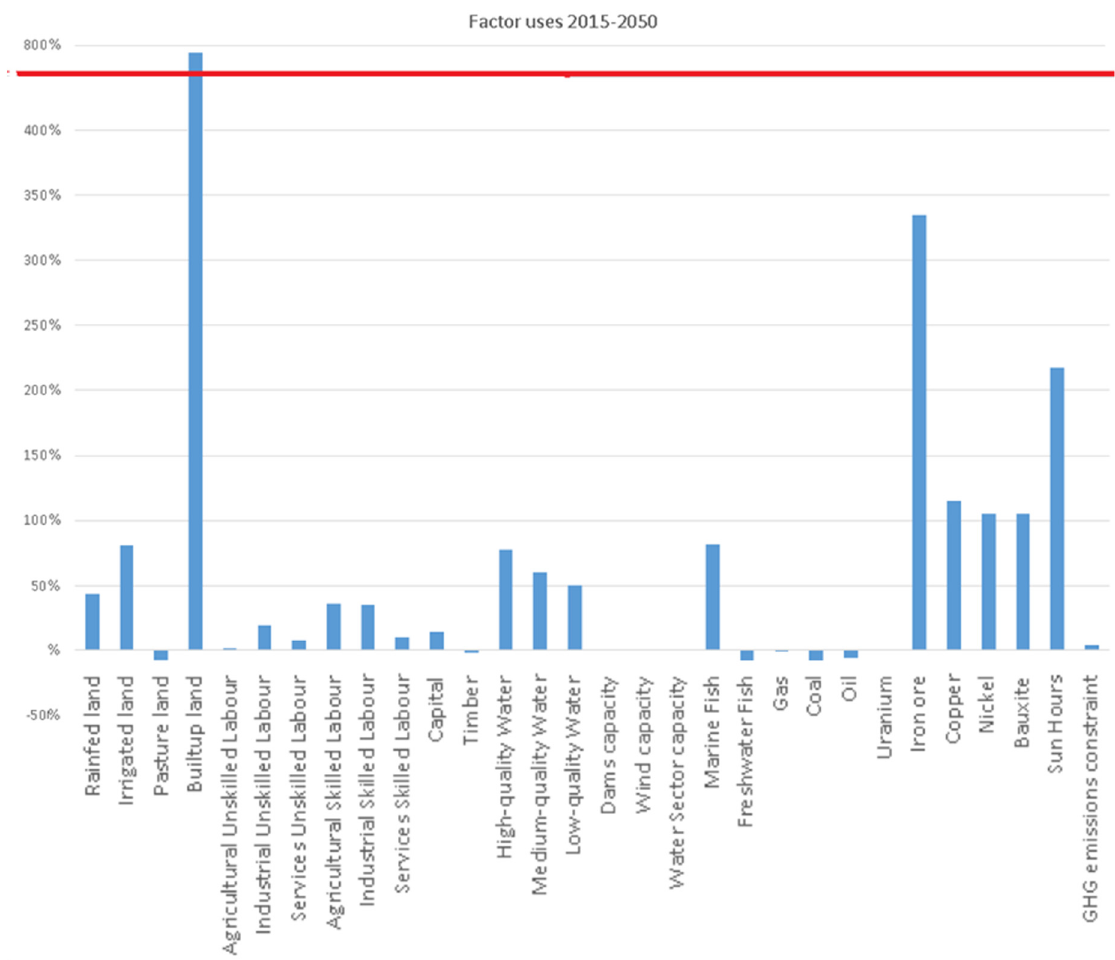
Figure 3. Factor uses change from 2015 to 2050 with the WTM/RCOT for SSP1. Source: own elaboration based on the WTM/RCOT results.